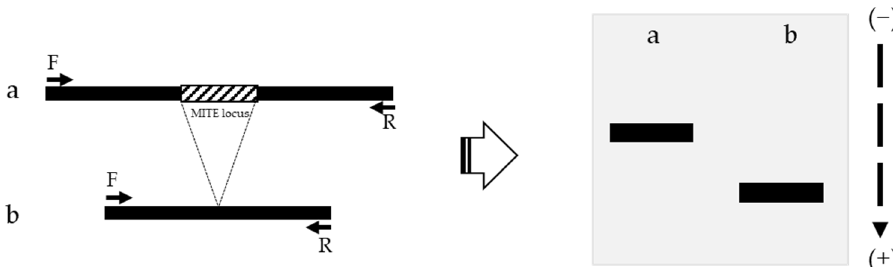
Figure 1. Confirmation of PTE-2 excision by in silico analysis. UP, 10 bp upstream from PTE-2 start locus; ON, middle of PTE-2 locus; DN, 10 bp downstream from PTE-2 end locus.